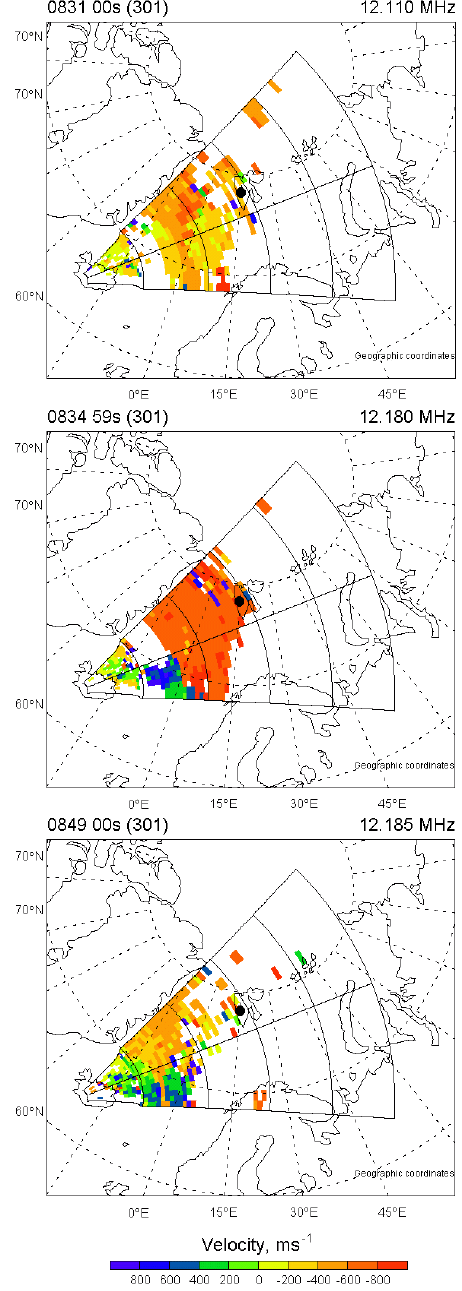
Fig. 4. The interplanetary magnetic field ( B z , B y ), solar wind dy- namic pressure (P), magnetometer X component at IMAGE stations Kilpisj¨arvi (KIL) and Longyearbyen (LYR), and the Pc1 pulsations at Barentsburg (BAB) are presented.